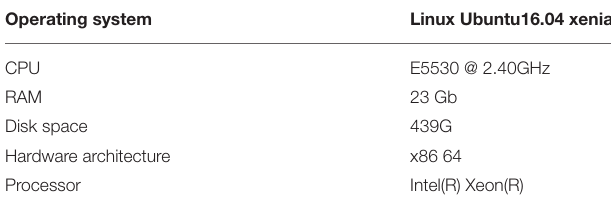
TABLE 2 | Elastic stack server specification.